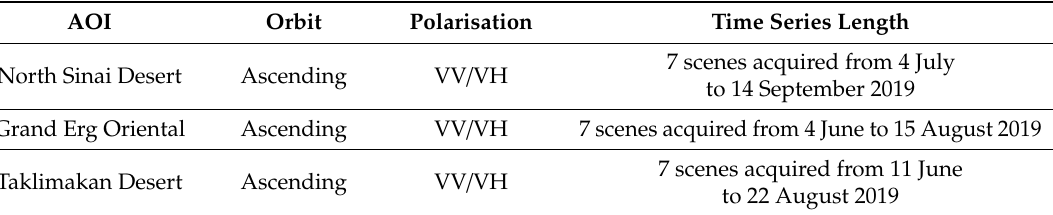
Table 1. Details of the Sentinel–1 time series used in each of the